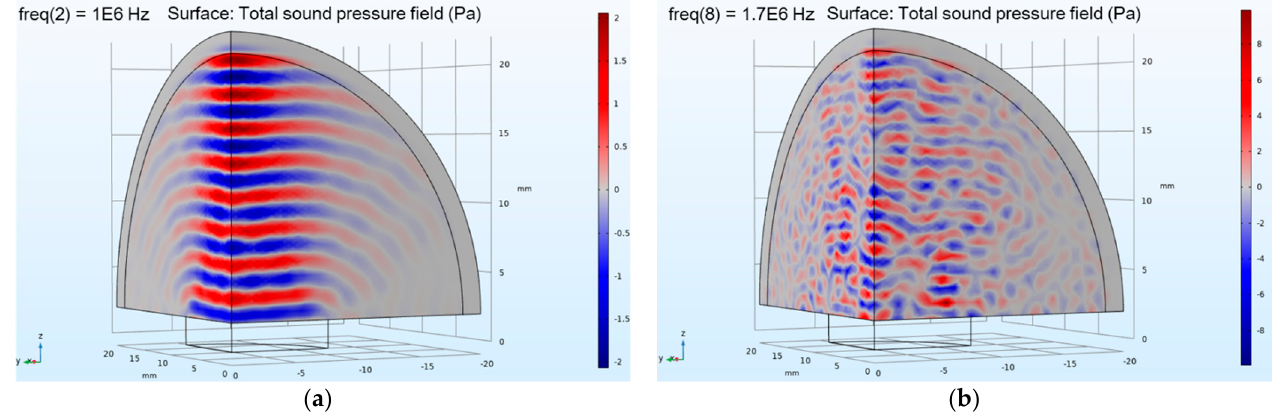
Figure 4. The total sound pressure field: ( a ) the resonant frequency of the transducer is 1 MHz; ( b ) the resonant frequency is 1.7 MHz.